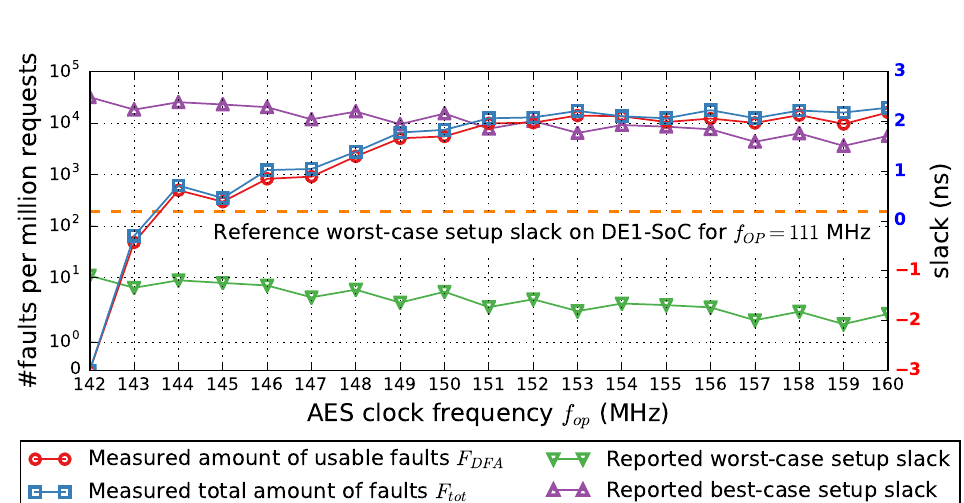
Figure 13: Total measured fault injection rates F tot and measured injection rate of faults usable in DFA F DFA as well as setup slacks reported by Quartus STA for different AES operating clock frequencies f op with preserved design placement but remaining routing randomization on the